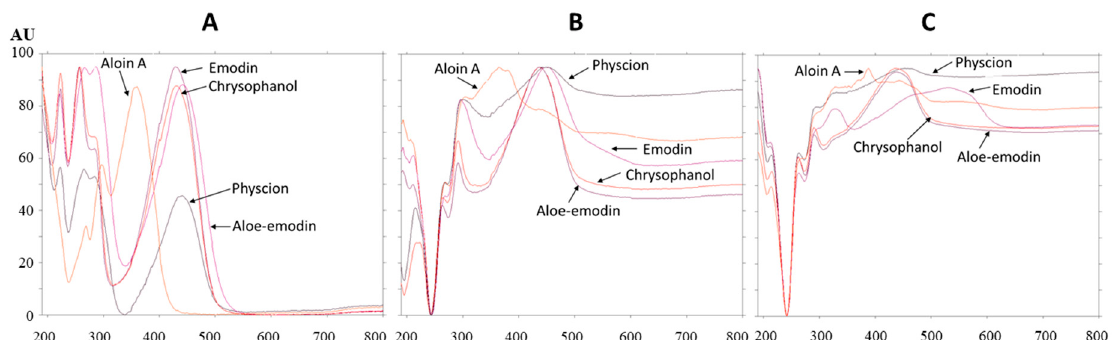
Figure 9. Absorption spectra of standards scanned in situ on the HPTLC silica gel plate developed with toluene–acetone–formic acid (6:6:1, v / v ) after development ( A ), after post-chromatographic derivatization with NP reagent ( B ) and 30 min after use of PEG reagent ( C ). The application of each standard was 1 µ g.